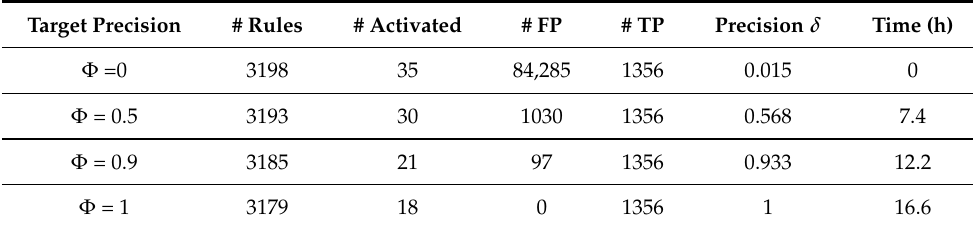
Table 8. Precision with different